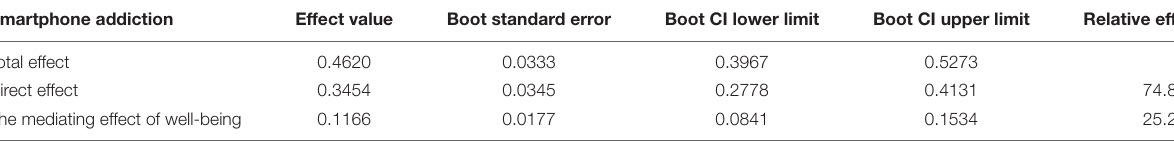
TABLE 2 | Mediating role of well-being.